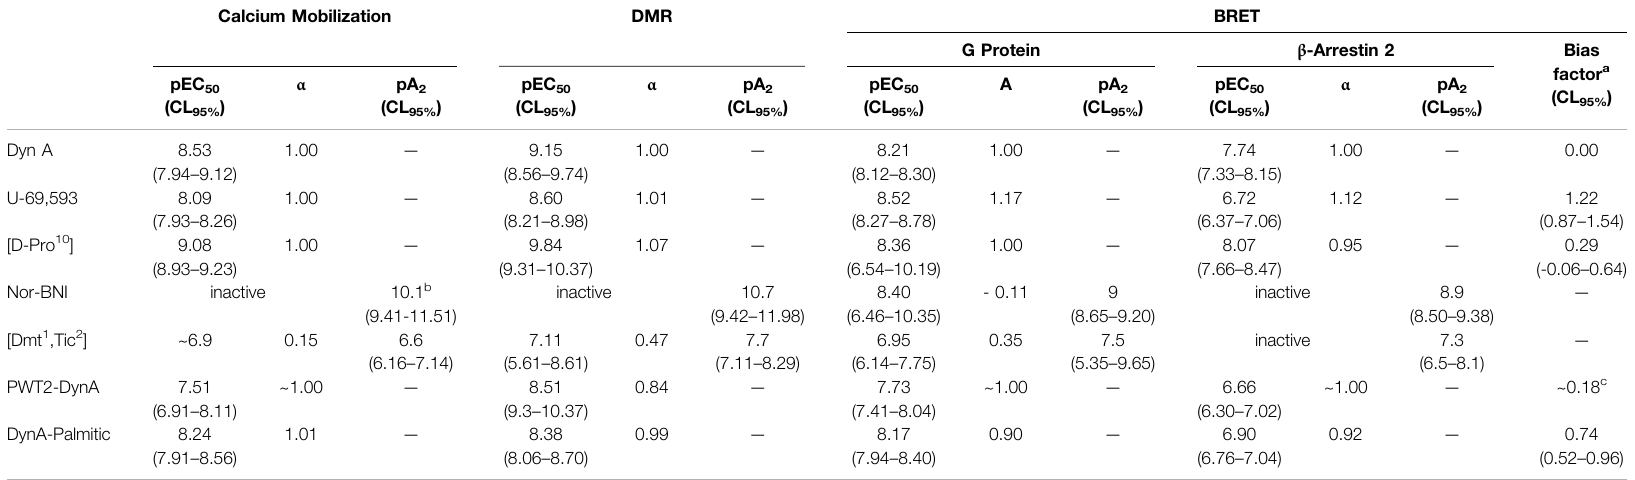
TABLE 1 | Pharmacological parameters and relative CL 95% for Dyn A, U-69,593, [D-Pro 10 ], Nor-BNI, [Dmt 1 , Tic 2 ], PWT2-DynA, and DynA-Palmitic in the indicated